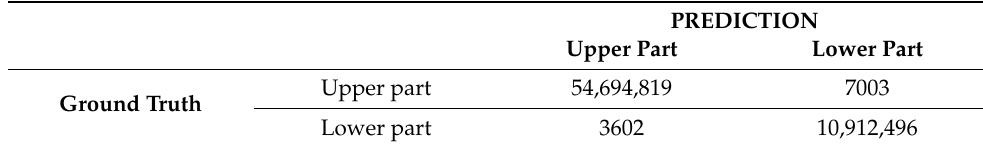
Table 2. Confusion matrix of segmentation network 1 dividing upper and lower part of skull using pointnet.